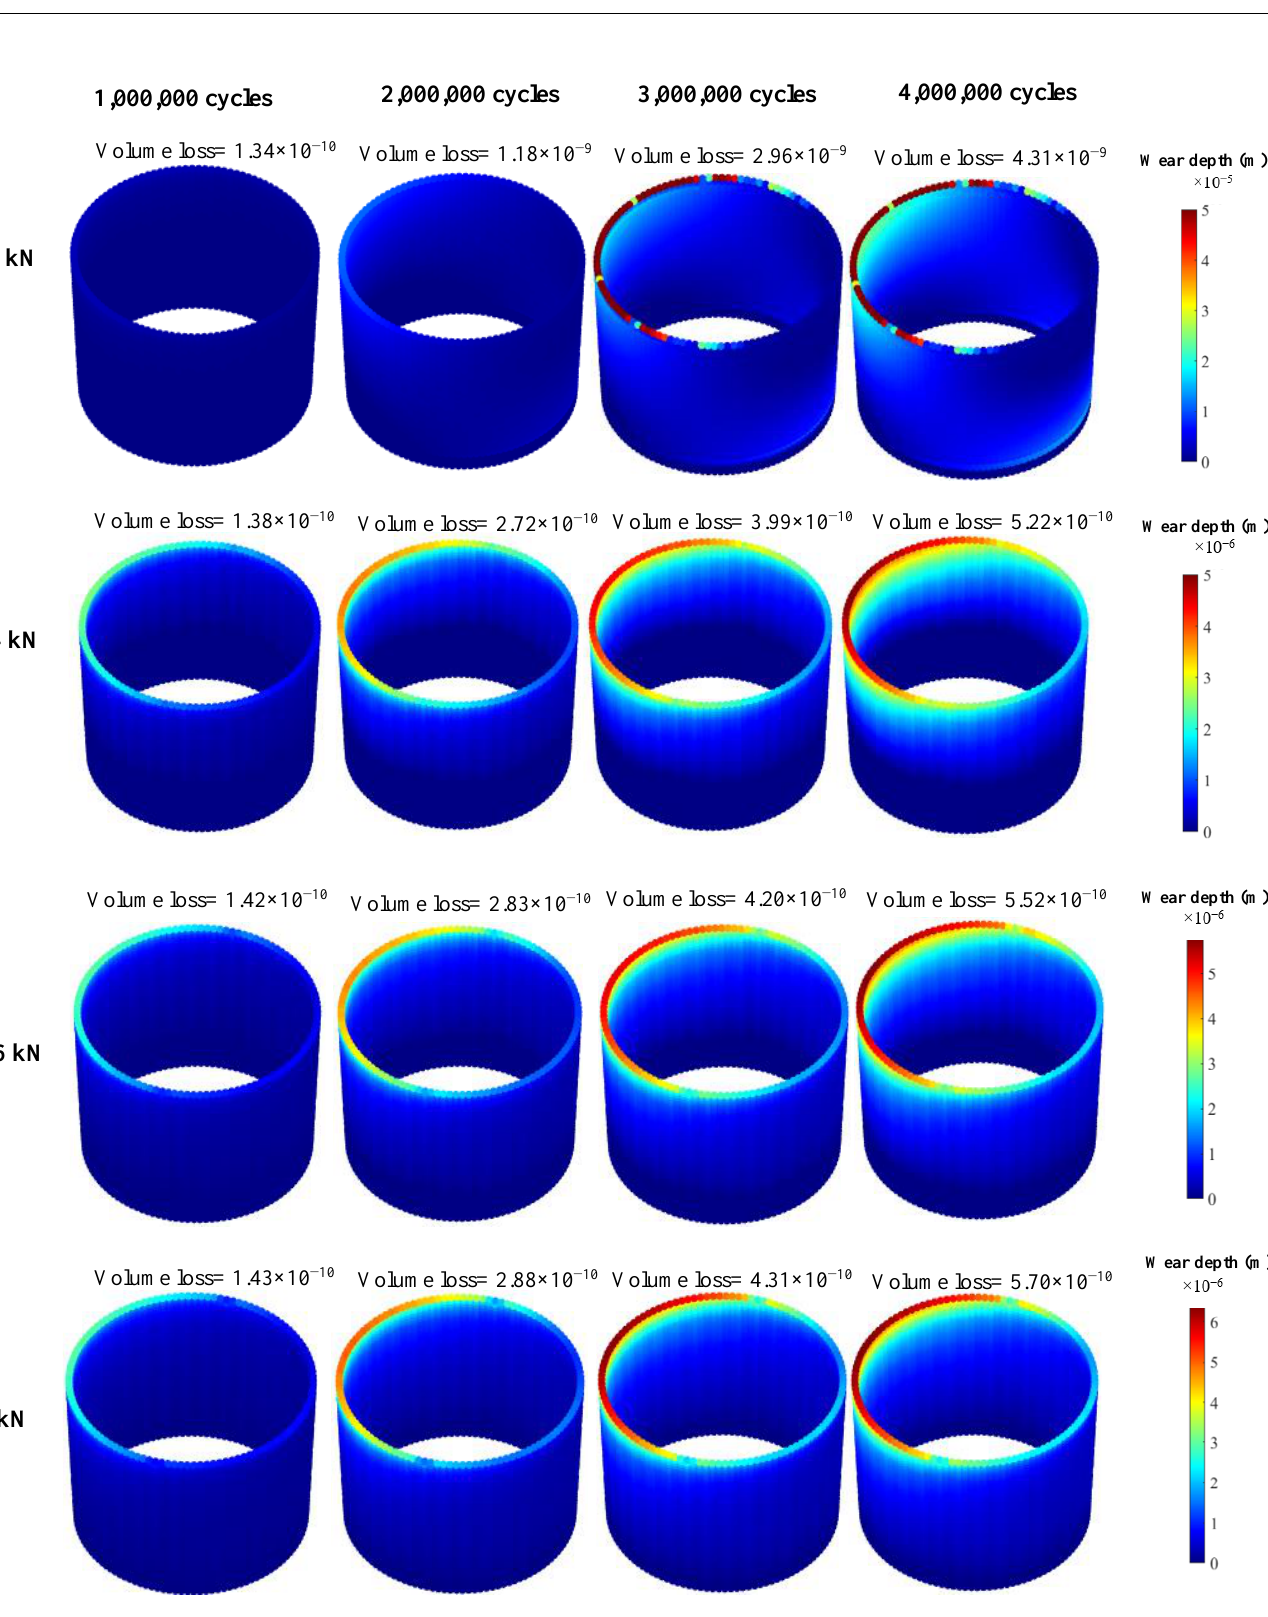
Figure 4. Mechanical wear profiles of the head contact surface (the wear results are presented in meters and the volume losses are in m 3 ).